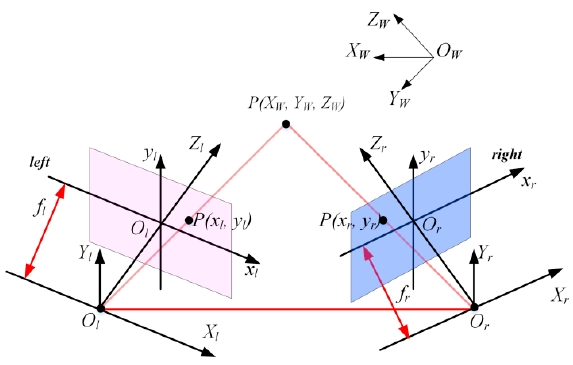
Figure 5. Principle of binocular stereo vision.